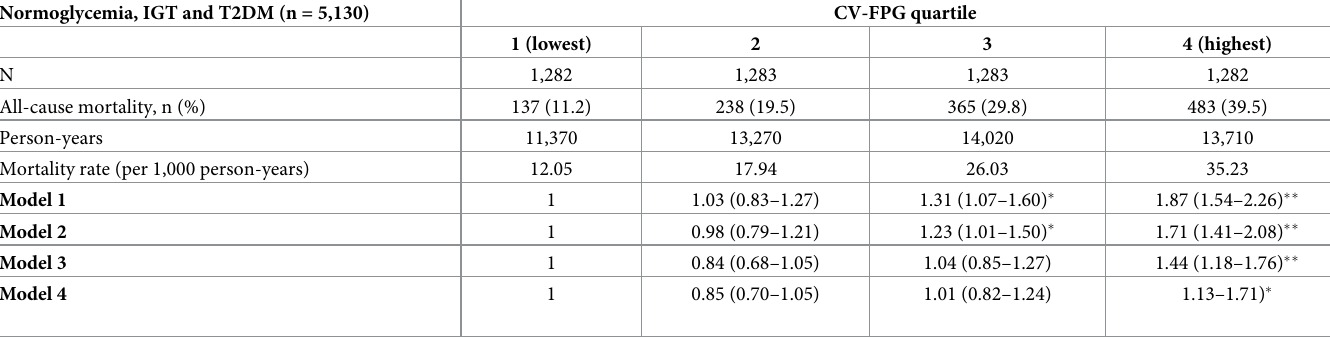
Table 4. Hazard ratios of all-cause mortality grouped by CV-FPG in patients with normoglycemia, IGT and T2DM. Normoglycemia, IGT and T2DM (n =